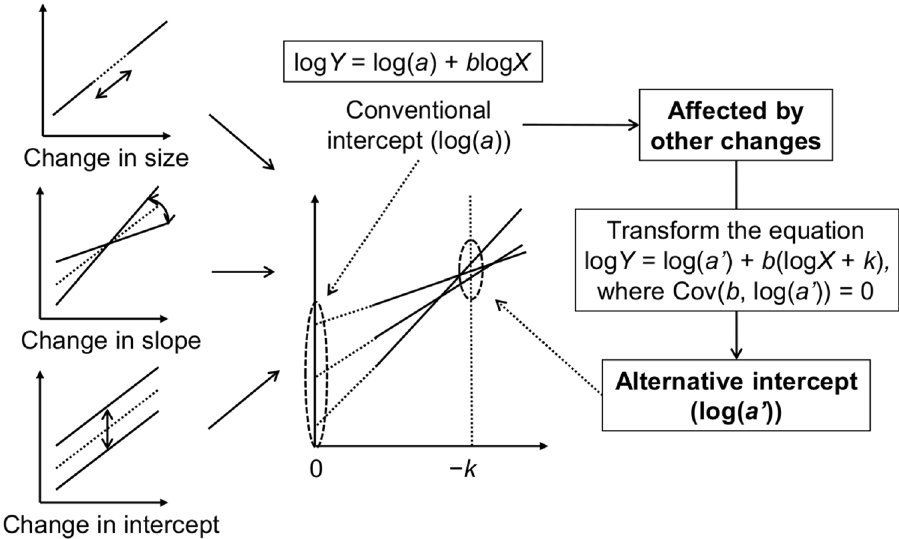
Figure 1. Conceptual description of the allometric intercept independent of the slope (the alternative intercept, log( a’